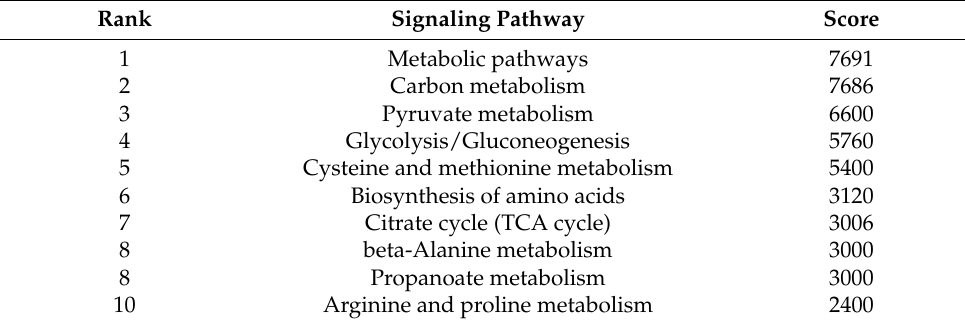
Table 1. Top 10 hub pathways of up-regulated genes ranked by MCC method.